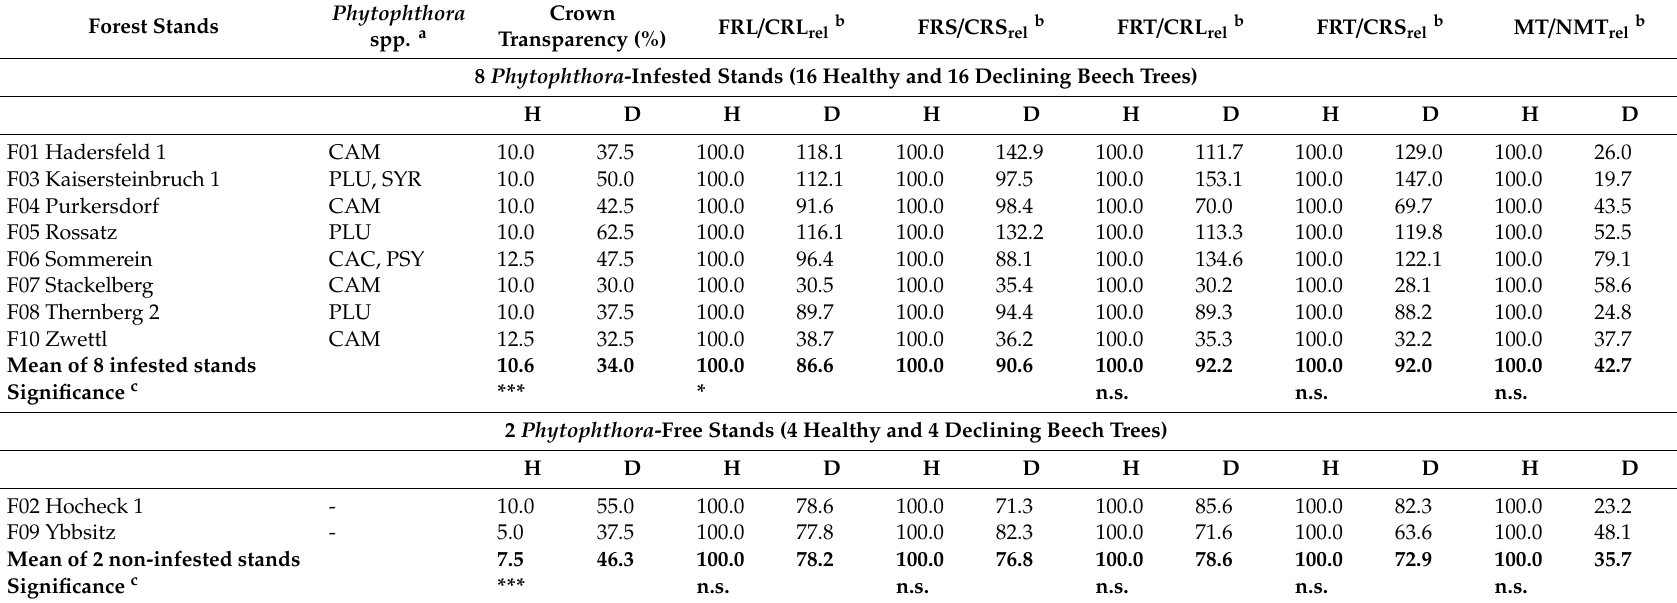
Table 3. Crown transparency and relative values of root parameters and ectomycorrhizal frequency of healthy and declining beech trees in eight Phytophthora -infested and two non-infested forest stands in Lower Austria, and the significance of di ff erences (Type III likelihood-ratio test). Phytophthora Forest Stands spp. a